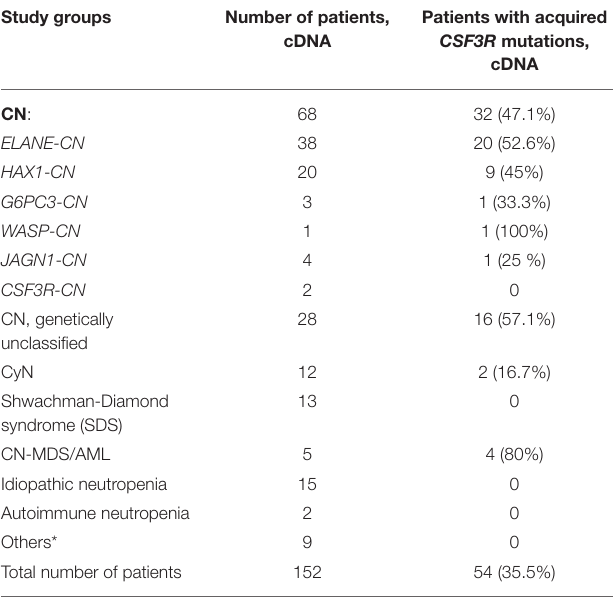
TABLE 1 | Prevalence of CSF3R acquired mutations in studied groups using cDNA deep sequencing. Study